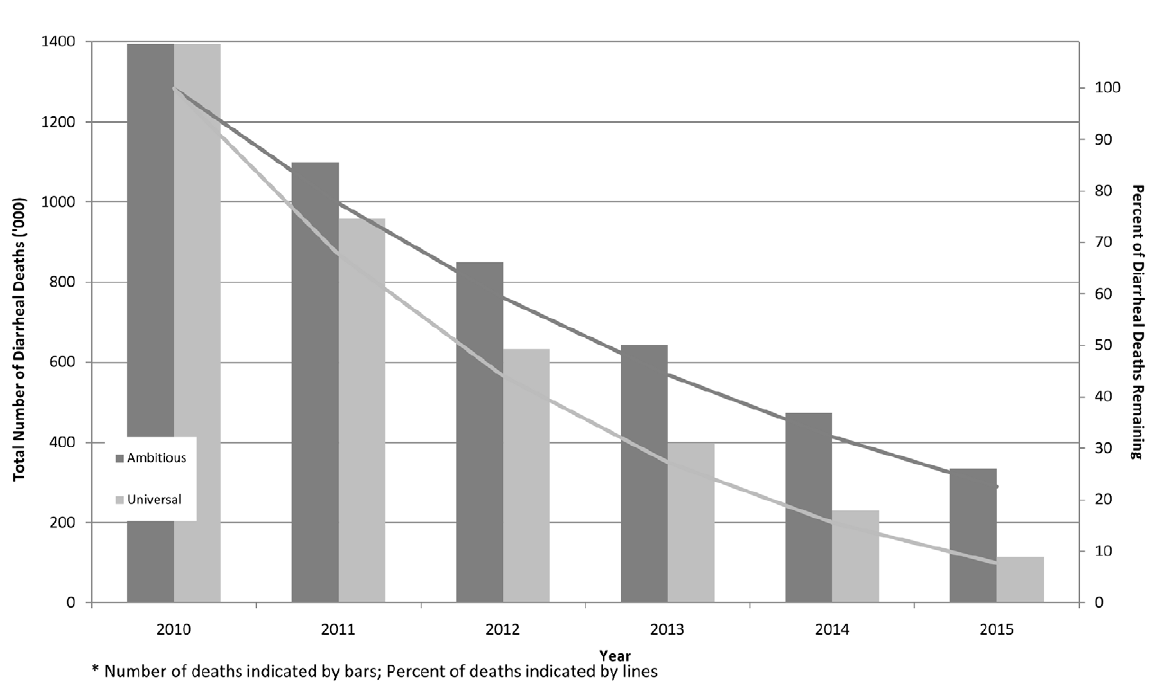
Figure 1. Trends in number and proportion of diarrheal deaths, under ambitious and universal scale-up plans.